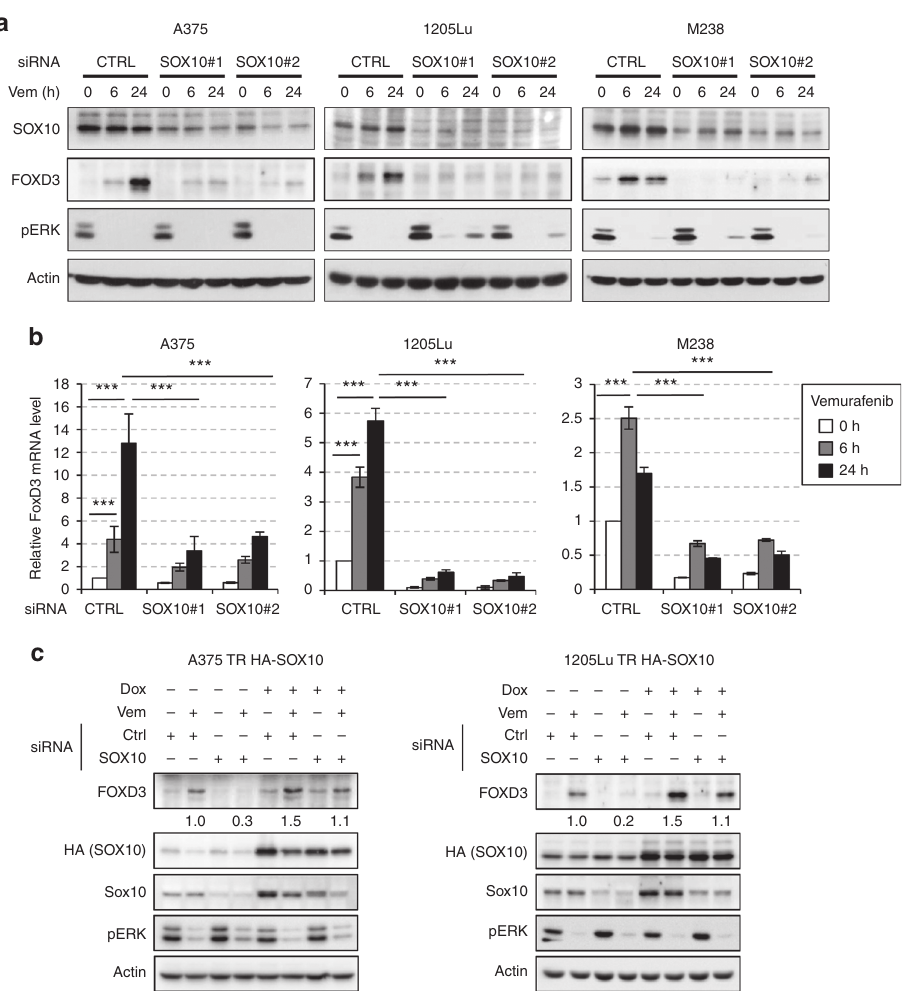
Fig. 1 SOX10 is necessary and suf fi cient for FOXD3 induction by ERK signaling inhibition. a Melanoma cells were transfected with non-targeting control or SOX10-speci fi c siRNAs for 72 h and treated with 2 μ M Vemurafenib for 0, 6, and 24 h before being lysed for western blot analysis. b Same as ( a ) except that after siRNA transfection and Vemurafenib treatment, cells were collected to isolate total RNA for qRT-PCR analysis on FOXD3 using actin as the internal control. Average results from three independent experiments are shown. Error bars represent standard deviation. Signi fi cance was determined by ANOVA one-way test, *** p < 0.001. c 1205Lu-TR HA-SOX10 and A375-TR HA-SOX10 cells were transfected with control or SOX10 siRNAs for 72 h in the presence or absence of 100 ng mL − 1 Doxycycline. The cells were then treated with 2 μ M Vemurafenib for 24 h and lysed for western blot analysis. Quantitations of FOXD3 expression based on band intensity are shown below the blots. Uncropped images are shown in Supplementary Fig.